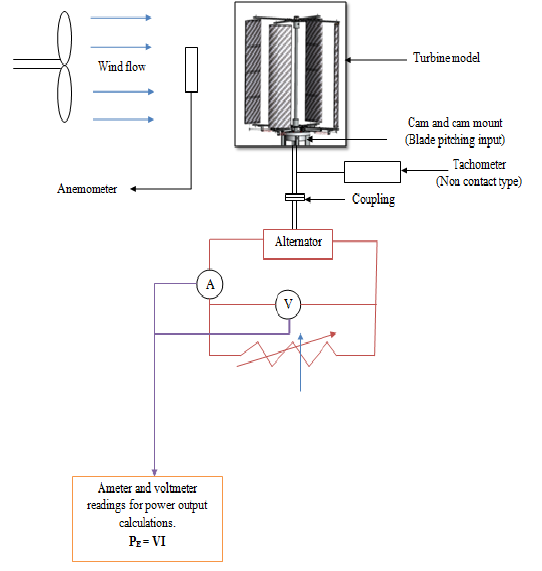
Figure 11. Test apparatus and flow diagram